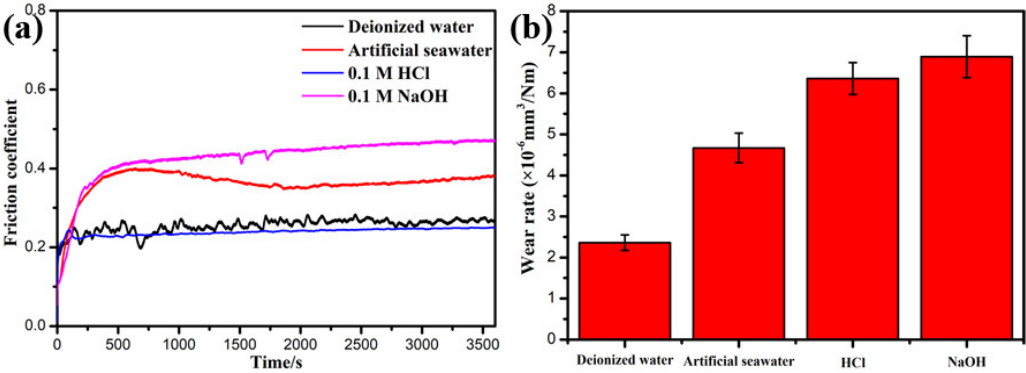
Figure 5. Friction curves ( a ) and wear rate ( b ) of NiCrAlY coating in different corrosive solutions.